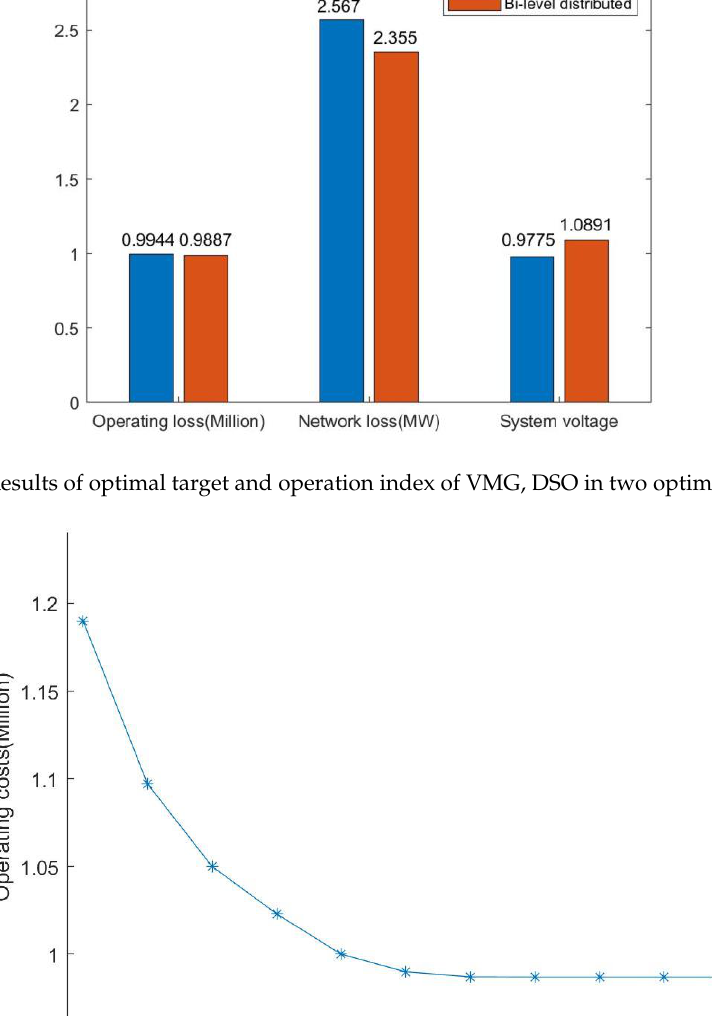
Figure 13. Convergence of ADMM.